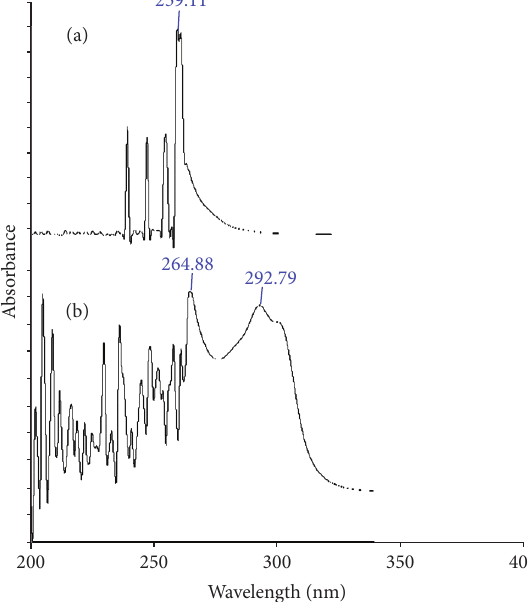
F 5: UV-Vis absorption spectra of (a) CPA and (b) CTA.